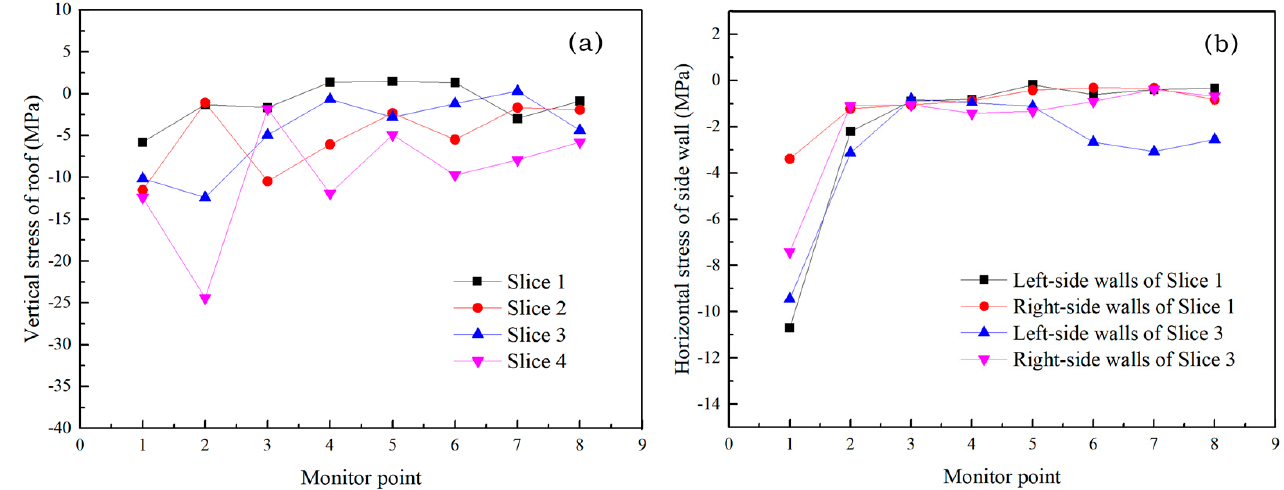
Figure 8. Stress curve for roof, left- and right-hand side walls of excavated Stope A. ( a ) Vertical stress of roof, ( b ) Horizontal stress of side wall